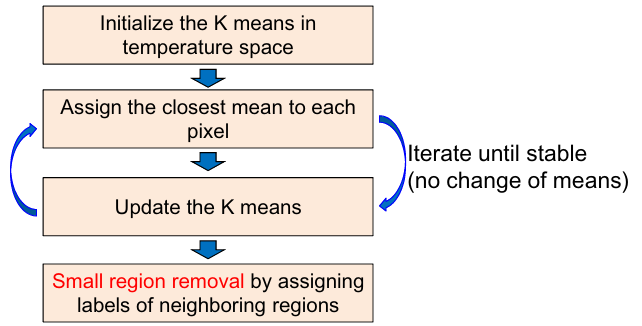
Figure 14. Region map extraction using K-means clustering and small region removal.